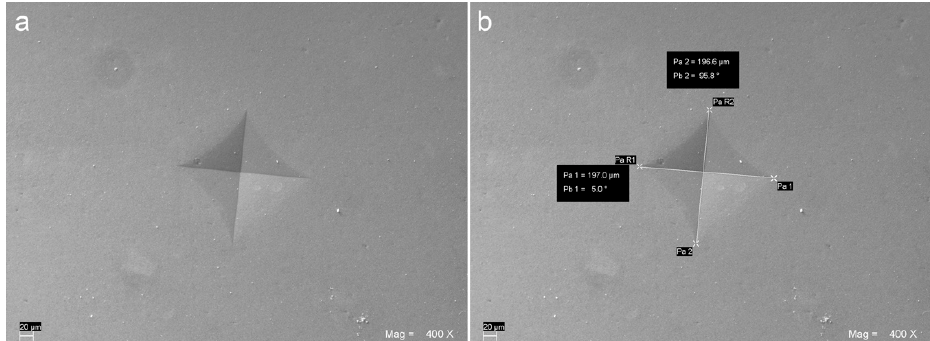
Figure 2. Scanning electron micro-graph showing a VH indentation ( a ) and the measurement of its diagonals ( b ) performed on a specimen from ENA group, 3 mm thick and cured for 40 s using a halogen curing unit with 600 mW/cm 2 output.